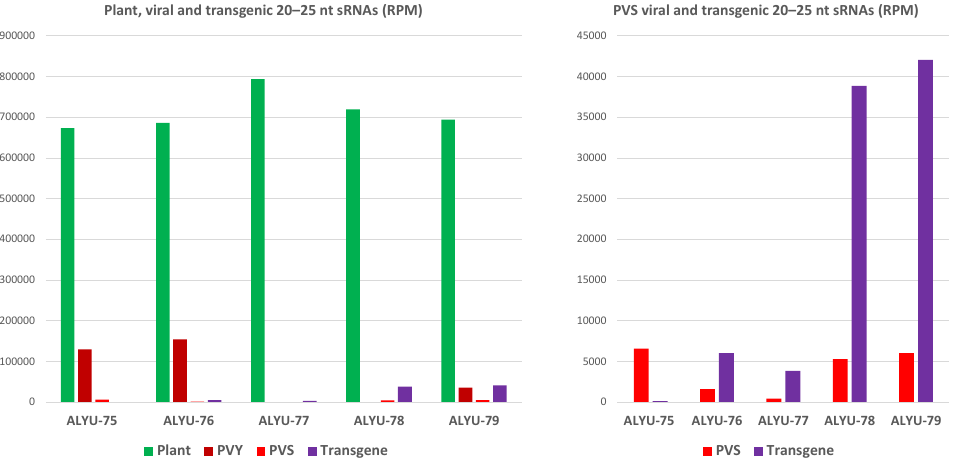
Figure 6. Relative abundance of plant, viral, and transgenic sRNAs. Redundant 20–25 nt sRNA reads from leaf samples of a non-transformed plant of cultivar Zeren (field plant ALYU-75) and the transgenic plant lines of cultivars Zeren (line #119: field plant ALYU-76 and in vitro plant ALYU-77), Dunyasha (line #61: field plant ALYU-78), and Kormilitsa (line #103: field plant ALYU-79) were mapped with zero mismatches to reference sequences of the S. tuberosum genome, the reconstructed genomes of viruses (PVS and/or PVY) present in some of the plants (Dataset S1B), and the S-25K-AS transgene expression cassette; and the sRNA reads mapped to each reference sequence were counted in reads per million (RPM) of total sRNAs in each library (Dataset S2D). The resulting counts are plotted as bar graphs and color-coded. Note that the transgenic plants ALYU-76, ALYU-77, ALYU-78, and ALYU-79 are not infected with PVS, and “PVS” reads (red bars) in these plants represent the PVS 25K transgene-derived siRNAs mapped to the 25K coding region of the PVS genome sequence reconstructed from the non-transgenic plant ALYU-75 infected with PVS.